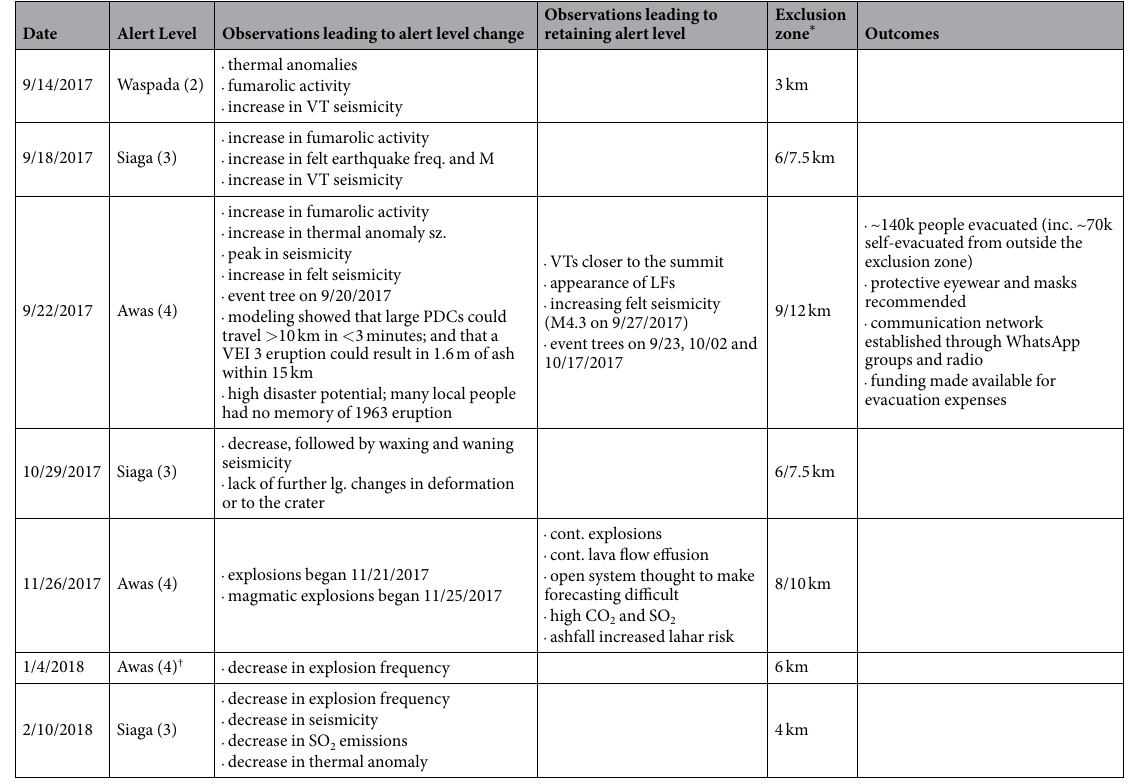
Table 1. Alert level changes, observations, exclusion zones and outcomes. * Greater exclusion zone distances given for N, SE, SW sectors. † Alert level remained the same, but the exclusion zone limit was